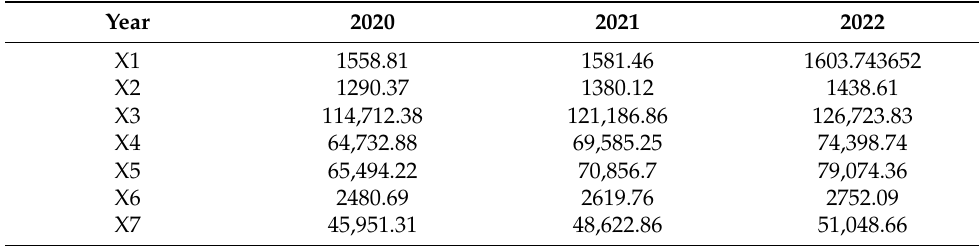
Table 6. Factor forecast for the next three years.